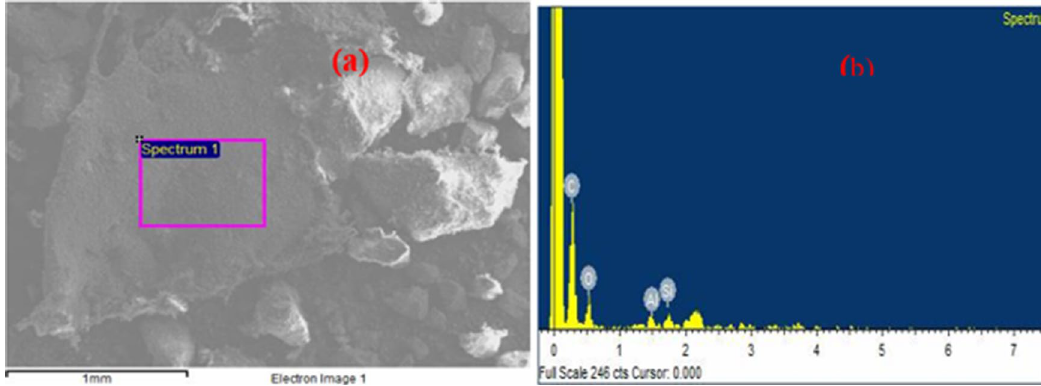
Figure 3. Elemental analysis of raw sewage sludge D: ( a ) and ( b ).